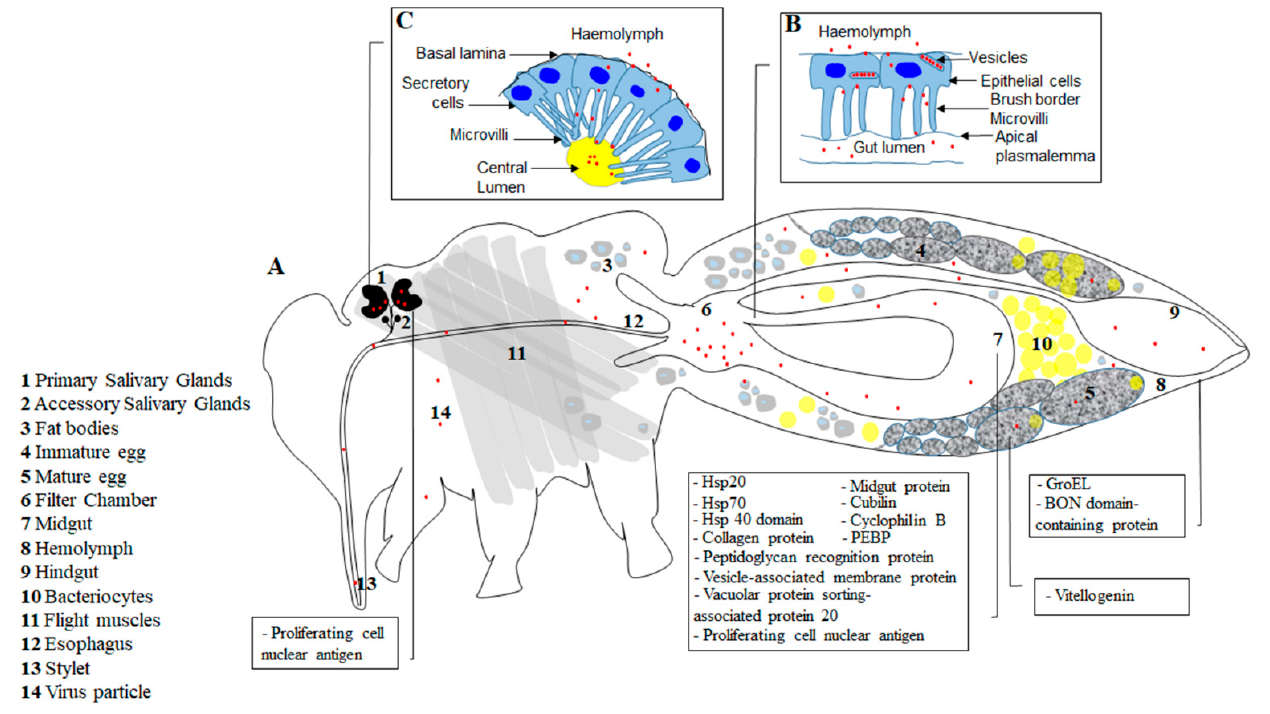
Figure 1. Whitefly internal anatomy ( A ) showing the major organs and proteins (in boxes) involved in circulative transmis- sion of plant viruses by B. tabaci . The virus (red particles, number 14) is ingested with the phloem sap and is transported to the midgut (7) via the stylet (13) and esophagus (12). In the filter chamber area (6), the virus particles cross the midgut barrier ( B ) into the hemolymph (8) via the midgut plasmalemma and epithelial brush border. The virus circulates in the hemolymph and reaches the primary salivary glands (1), where it is internalized into the glands via the basal lamina and secretory cells to reach the central lumen that empties into the salivary glands duct ( C ). The virus then moves from the salivary glands duct into the salivary canal and is egested outside of the body while feeding. The accessory glands (2) have no role in the transmission. Some virus particles that do not reach the hemolymph are secreted outside of the body with the honeydew via the hindgut. The virus (TYLCV) has been shown to enter developing oocytes (4) and eggs (5), and could be transovarially transmitted to the next generation. Endosymbionts (10) play an important role in the transmission by secreting GroEL into the hemolymph (see text for details).